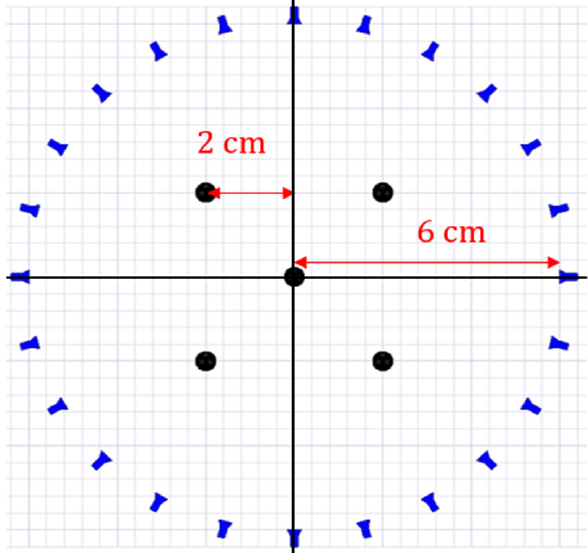
Figure 3. Simulated geometry of five point scatterers (black) and 24 antenna locations (blue). Each source emits a signal of 1–8.5 GHz and records a monostatic scattered field at its location.